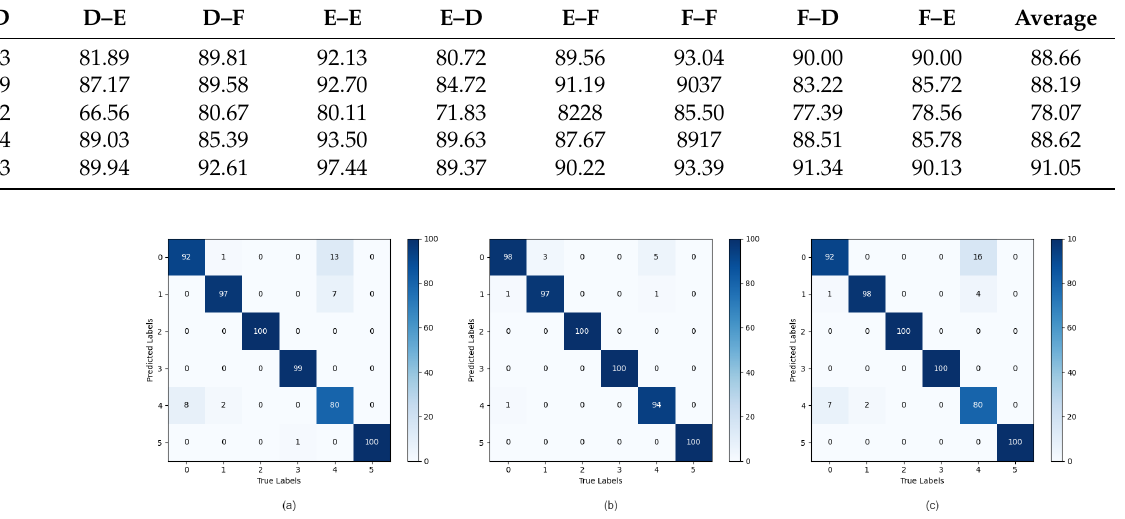
Figure 13. Confusion matrix results for the proposed method at working conditions ( a ) D, ( b ) E, ( c )